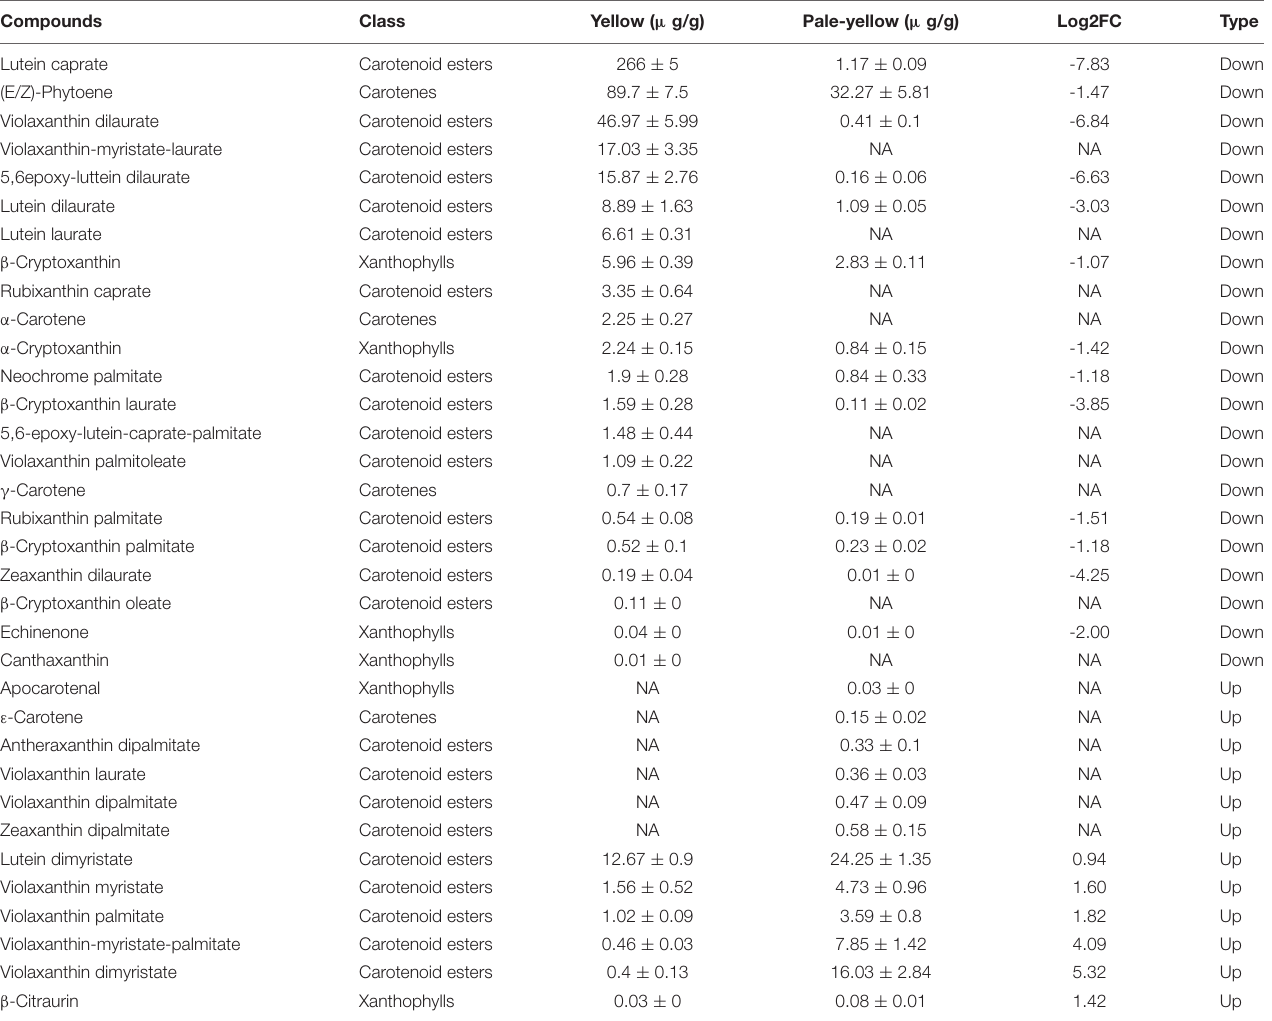
TABLE 2 | Difference of carotenoids accumulation and their derivative esters present in yellow and pale-yellow